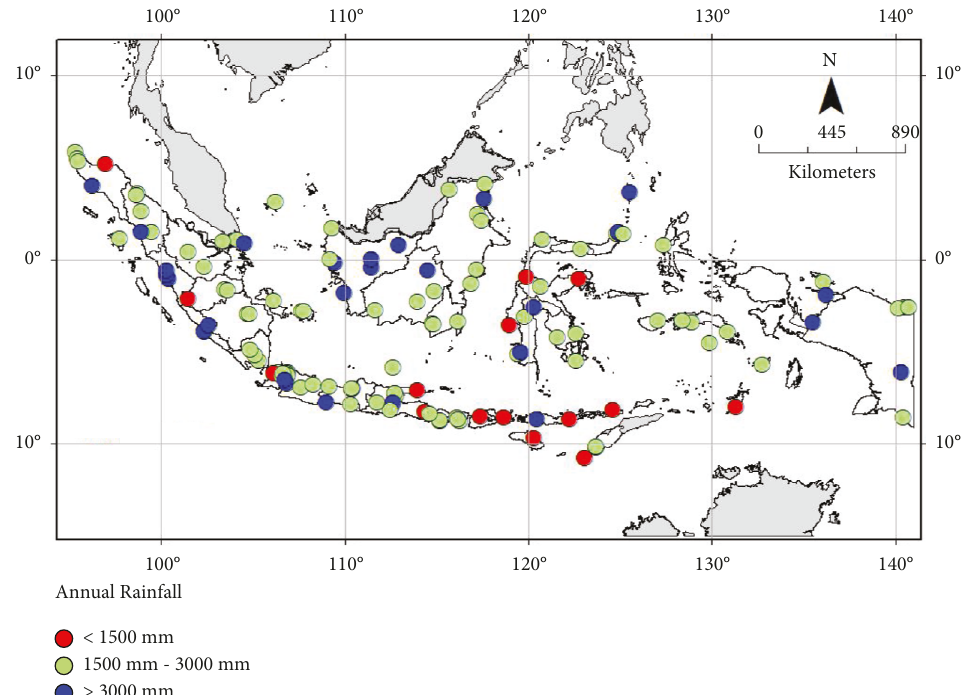
Figure 1: The location of station sites with observed mean annual rainfall distribution in the period of 2003–2015 with red ( green (150–3000mm/yr), and blue (